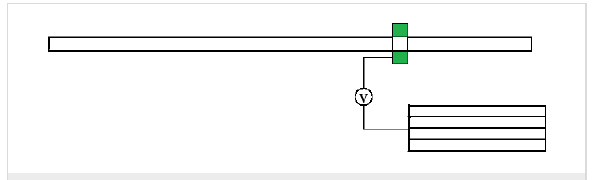
Figure 3: Connection between the nano sensor and larger